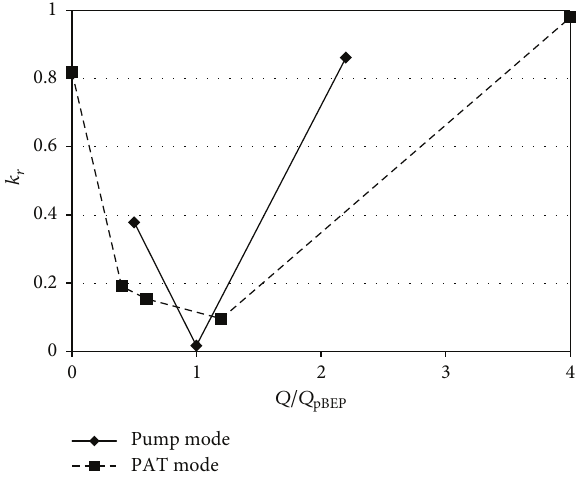
Figure 13: Averaged amplitude of the unsteady radial